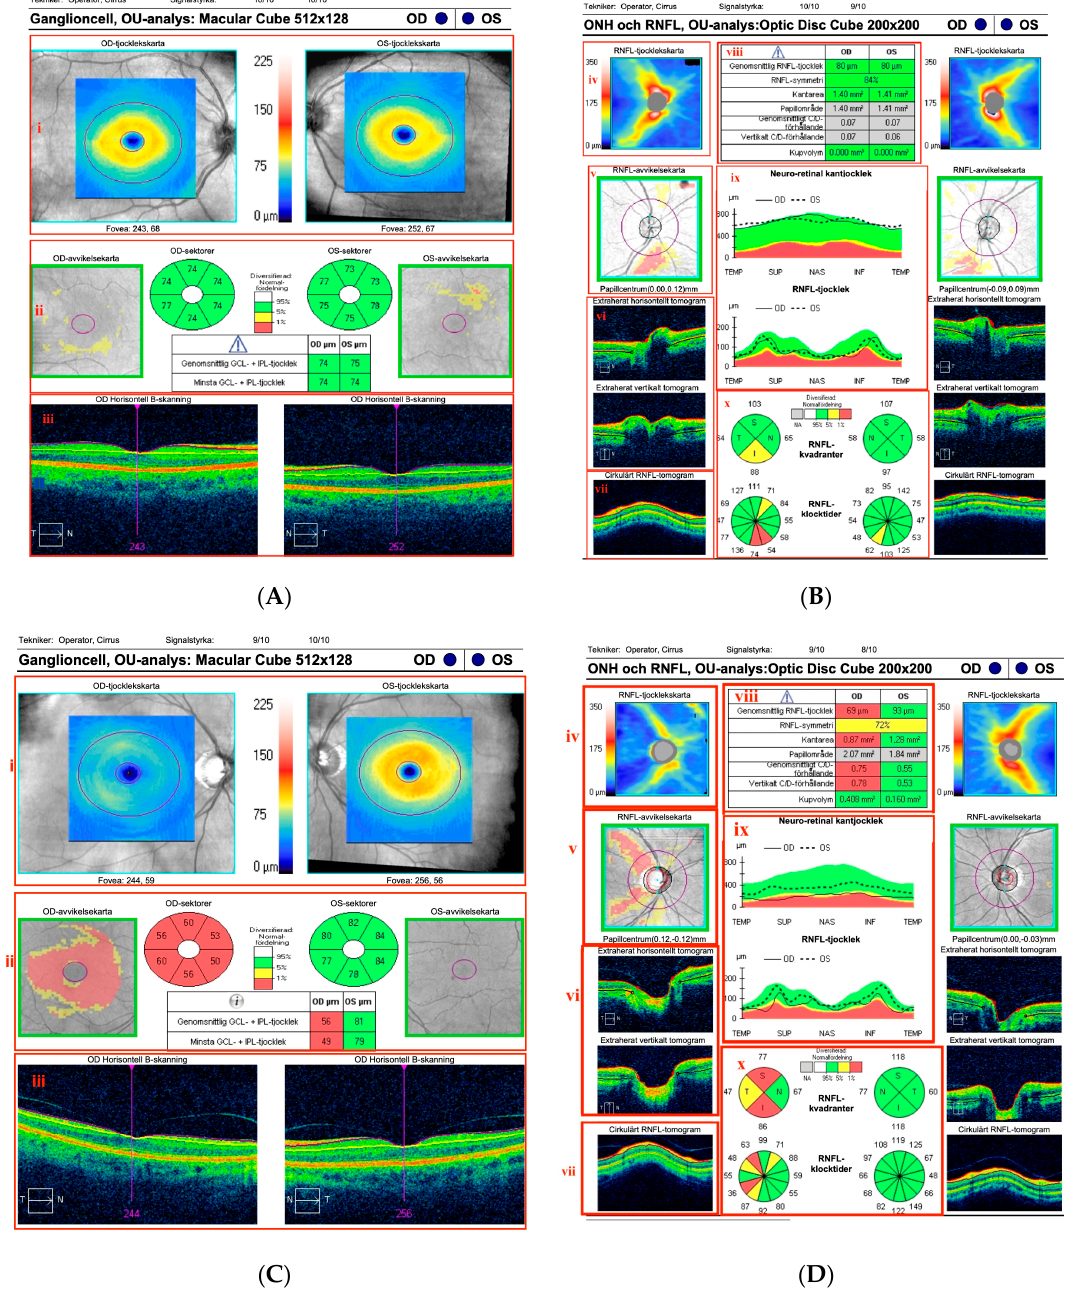
Figure 1 . The OCT B-scans of the ( A ) macular GCL-IPL and ( B ) OCT of optic disc of a healthy subject showing normal thickness in both macular GCL-IPL and peripapillary RNFL in both eyes. ( C ) Macular OCT in a patient with 20 years duration of BMS and right-sided optic neuritis, EDSS = 0 and without treatment. The thickness map (i) shows clear thinned GCL-IPL layer in right eye (OD) compared to left eye (OS). The same result is shown in the thickness deviation map (ii), where the thinner layer is shown in red compared to green in OS with average thickness. ( D ) The optic disc report in the same patient shows a thinner average RNFL in OD vs. OS in the data table (viii). (iii) Horizontal and vertical B-scan centered on macula, (iv) RNFL thickness map, (v) RNFL thickness deviation map from normal thickness, (vi) horizontal and vertical RNFL thickness tomogram, (vii) circular RNFL thickness tomogram, (viii) data table with average RNFL thickness and optic disk parameters, (ix) neuro-retinal and RNFL thickness graph with normative data, and (x) thickness graph in quadrants and clock